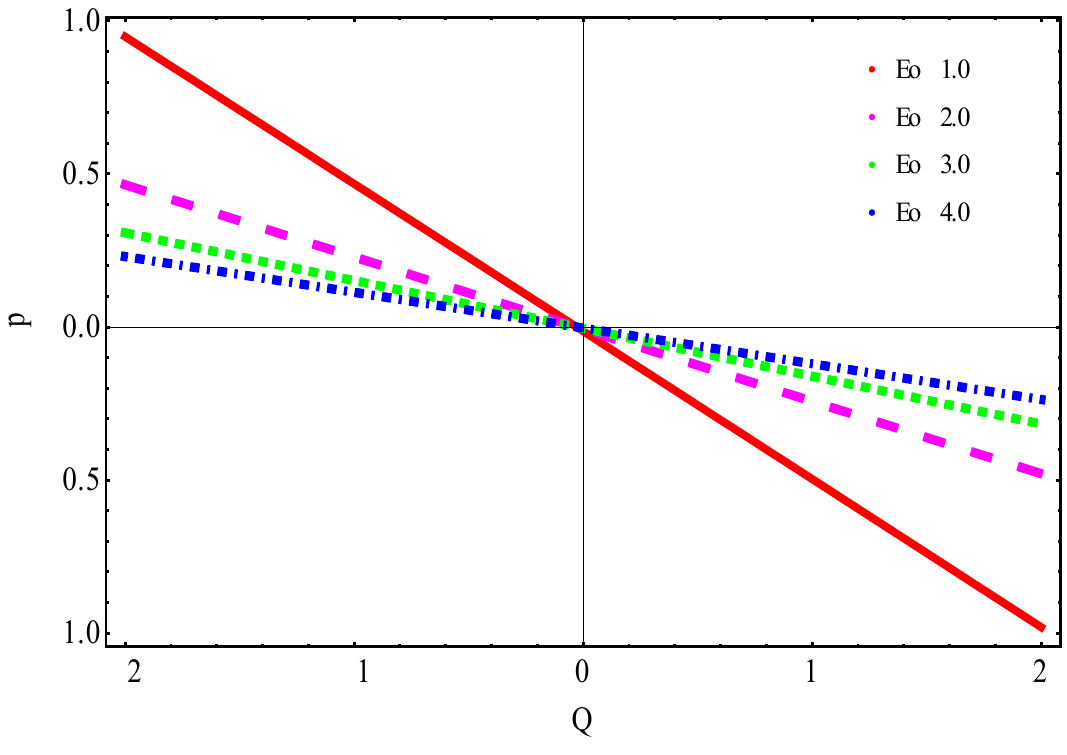
Figure 2. Pressure rise for several values of E o .